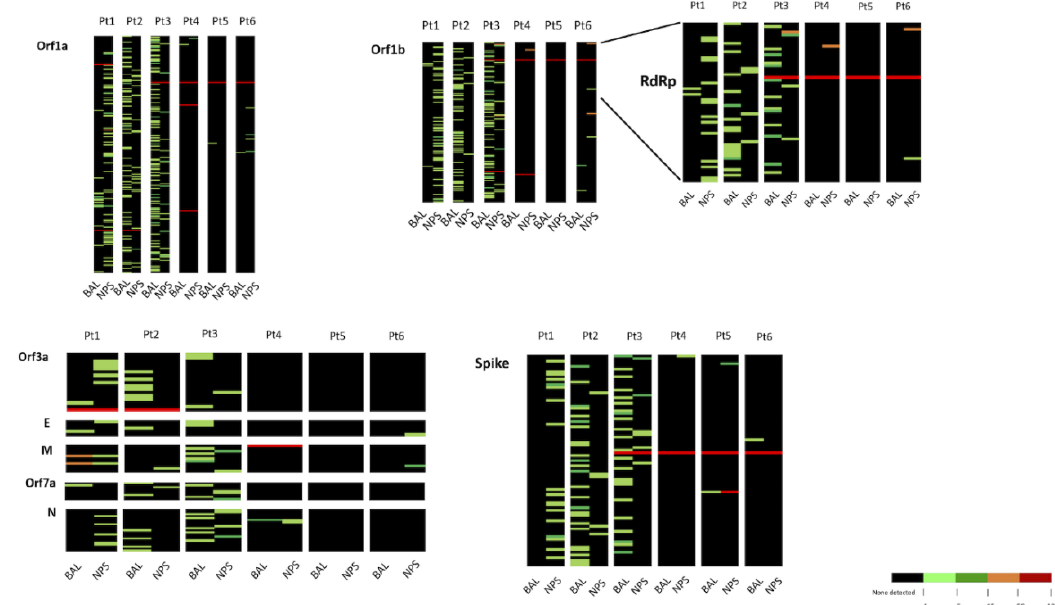
Figure 3. Heatmaps representing intra-host variants in SARS–CoV-2 genome vs. the reference Wuhan-Hu-1 sequence in upper and lower respiratory tract from six Covid-19 patients. Percent of frequency of variants is represented with a color-scale as stated in the figure. For each genomic region individual variants are listed in Table S3.